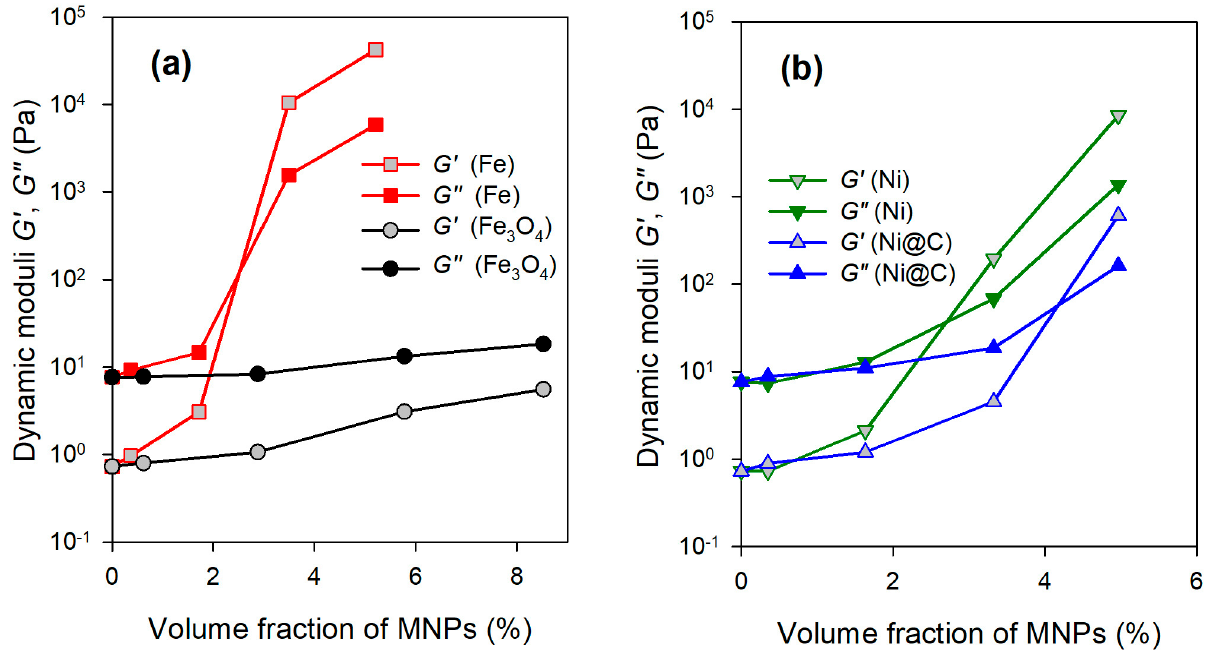
Figure 5. Concentration dependences of storage modulus G ′ and loss modulus G ″ for the magneto- rheological suspensions with different magnetic particles. ( a )—Fe and Fe 3 O 4 MPs, ( b )—Ni and Ni@C MPs. G ′ and G ″ are averaged over the plateau in 0.1–1 Pa range of shear stress. Frequency 1 Hz. Temperature 25 °C.